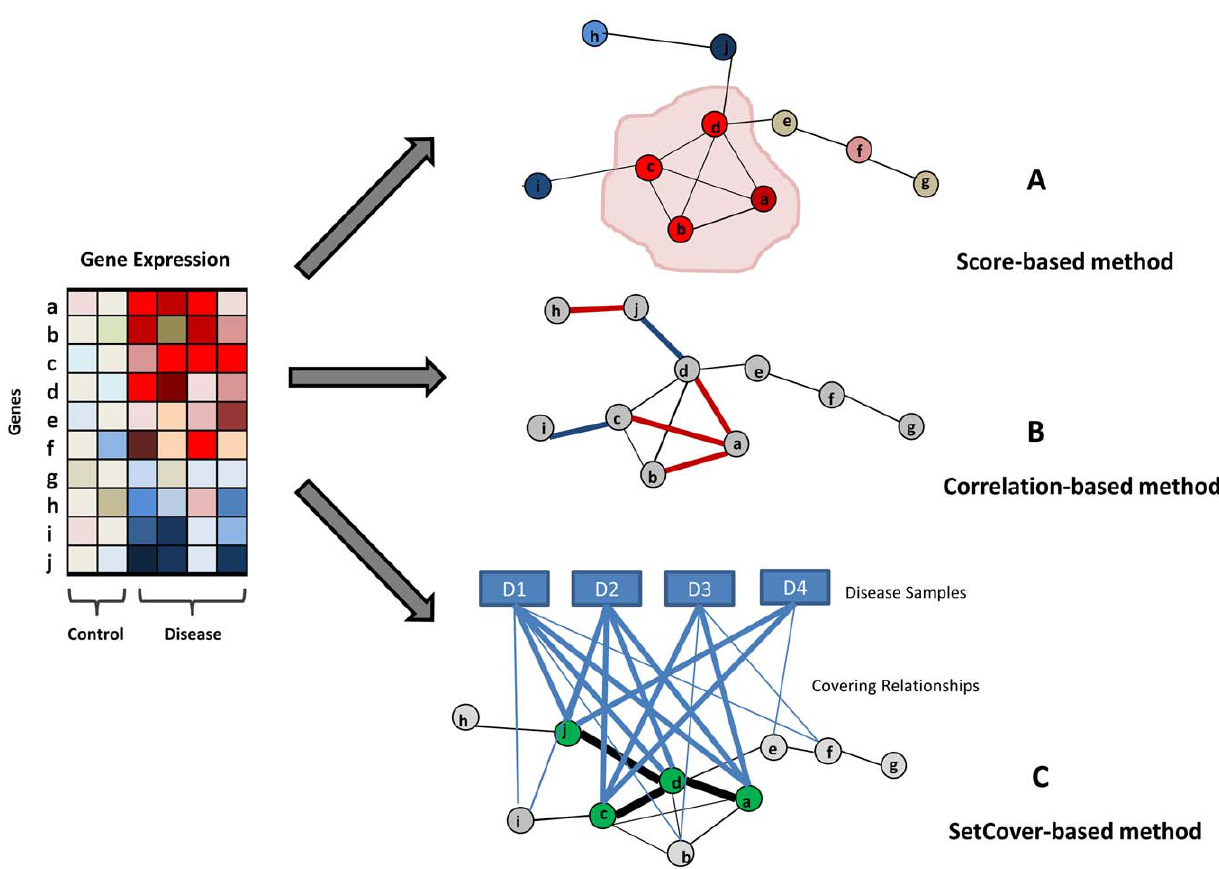
Figure 2. Finding differentially expressed modules. (A) Score based method selects the module with significant expression changes. (B) Correlation based method selects edges with correlation changes. The red and blue edges are correlated and anti-correlated edges, respectively. (C) Set cover based method selects a set of genes covering all samples. In this example, each sample has at least 2 differentially expressed genes and the genes are connected in the